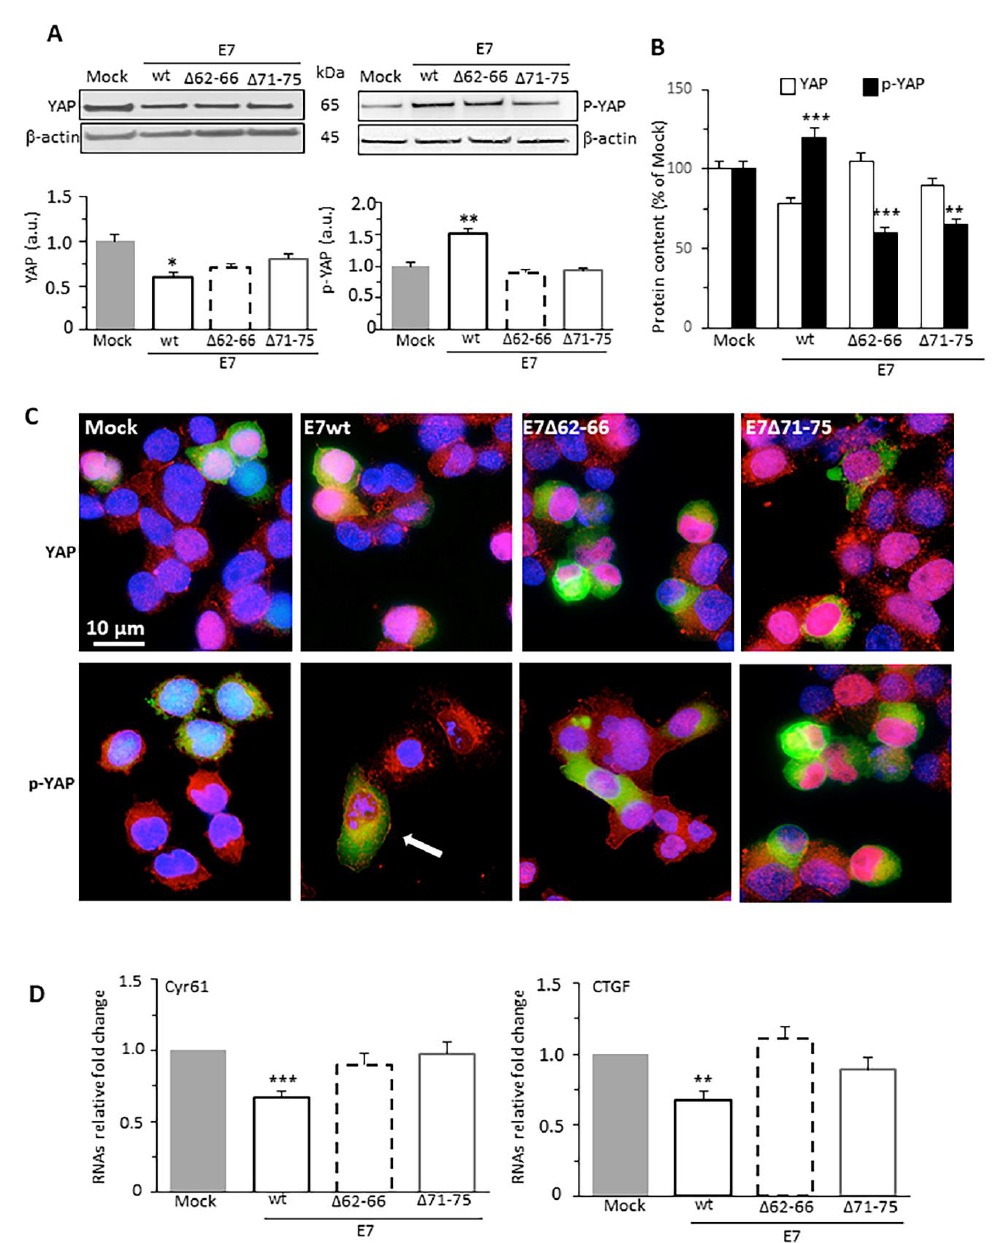
Figure 3. HPV16E7 promotes phosphorylation of YAP. ( A ) Western blot analysis of the expression level of YAP and p-YAP in Mock-transfected cells, and in cells transfected with E7wt or deletion mutant constructs E7 ∆ 62–66 or E7 ∆ 71–75. β − actin determination was used as loading controls. Bar graph (bottom) shows relative densitometry quantitation of each protein normalized to β-actin obtained in three independent experiments. * p < 0.05 and ** p < 0.01, vs Mock transfected cells. ( B ) Bar graph showing flow cytometry evaluation of YAP and p-YAP amount restricted to pAmCyan-positive cells. Results are the means ± SD of the median fluorescence intensity obtained in four different experiments. ** p < 0.01, and *** p < 0.001, vs Mock transfected cells. ( C ) IVM analysis after double cell staining with anti-YAP (upper line) or anti-p-YAP antibody (bottom line) (both in red) and Hoechst (blue) of cells transfected (green) with pAmCyan empty vector (Mock), E7wt or deletion mutant constructs E7 ∆ 62–66, E7 ∆ 71–75. Interestingly, p-YAP is found exclusively in the cytoplasm only in E7wt cells (yellow fluorescence, see arrow). ( D ) Bar graphs showing the evaluation of mRNA levels of Cyr61 (left) and CTGF (right), two downstream YAP target genes, performed by real-time qRT-PCR assay. Data are reported as mean ± SD of RNAs relative fold change vs Mock-transfected cells, obtained in three independent experiments. ** p < 0.01 and *** p < 0.001 vs. Mock transfected cells. Uncropped western blot images for Figure 3A available in Supplementary Figure